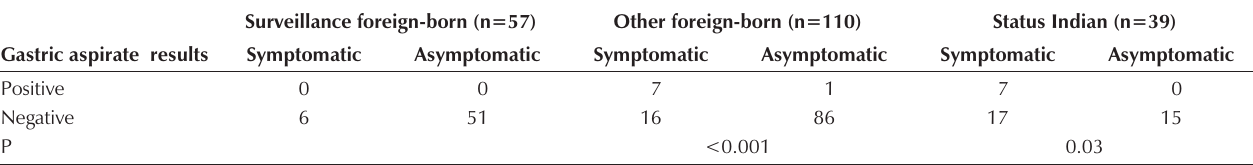
Color profile: Disabled Composite Default